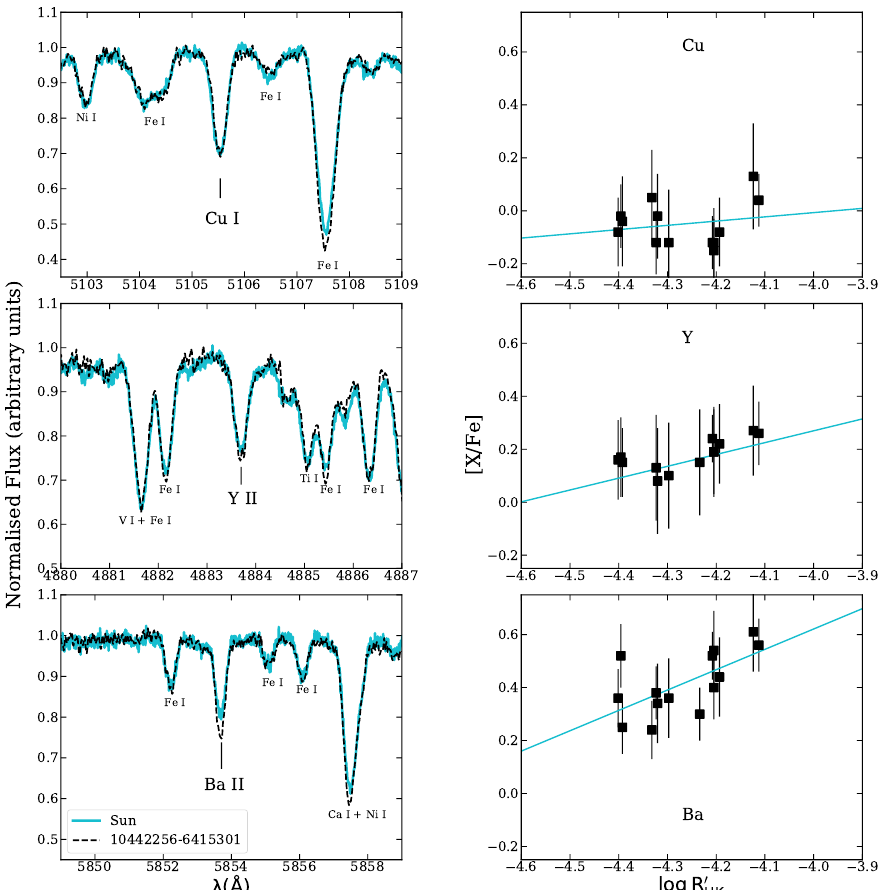
Figure 1. Left-hand panels : Comparison of spectra for the sun (light blue line, with rotational profile artificially broadened) and star 10442256-6415301 in IC 2602 (black dashed line, age ∼ 35 Myr). Right- hand panels : [X/Fe] of all stars as a function of their activity index logR (cid:48) with a typical systematic error of 0.1 dex. The light blue lines are the linear fits of the